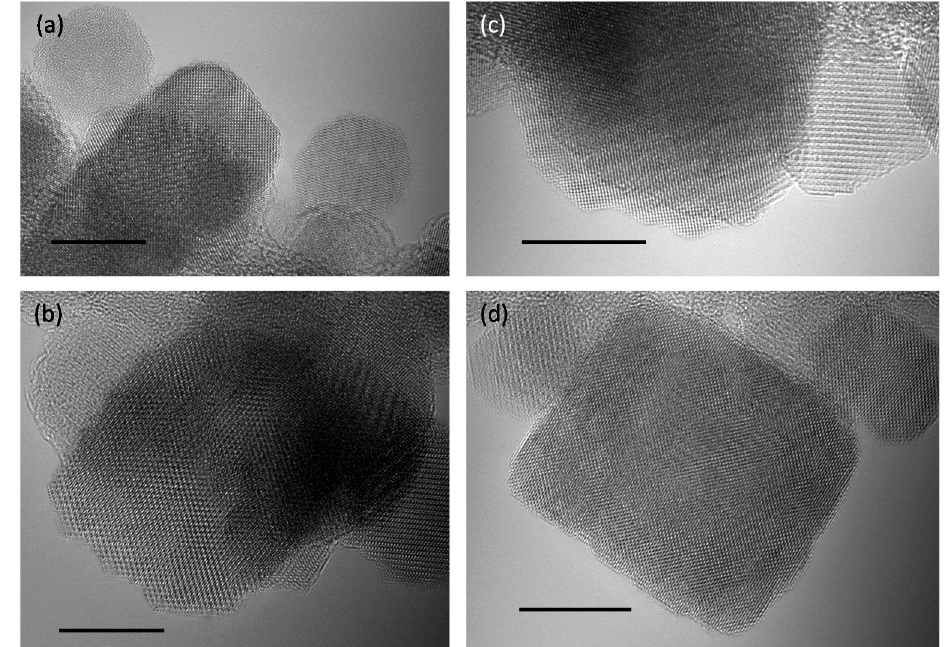
Figure 2 . Aberration-corrected TEM micrographs of nearly defect-free highly crystalline surface of IONPs’ samples 4 ( a , b ) and 6 ( c , d ). All scale bars are 10 nm.